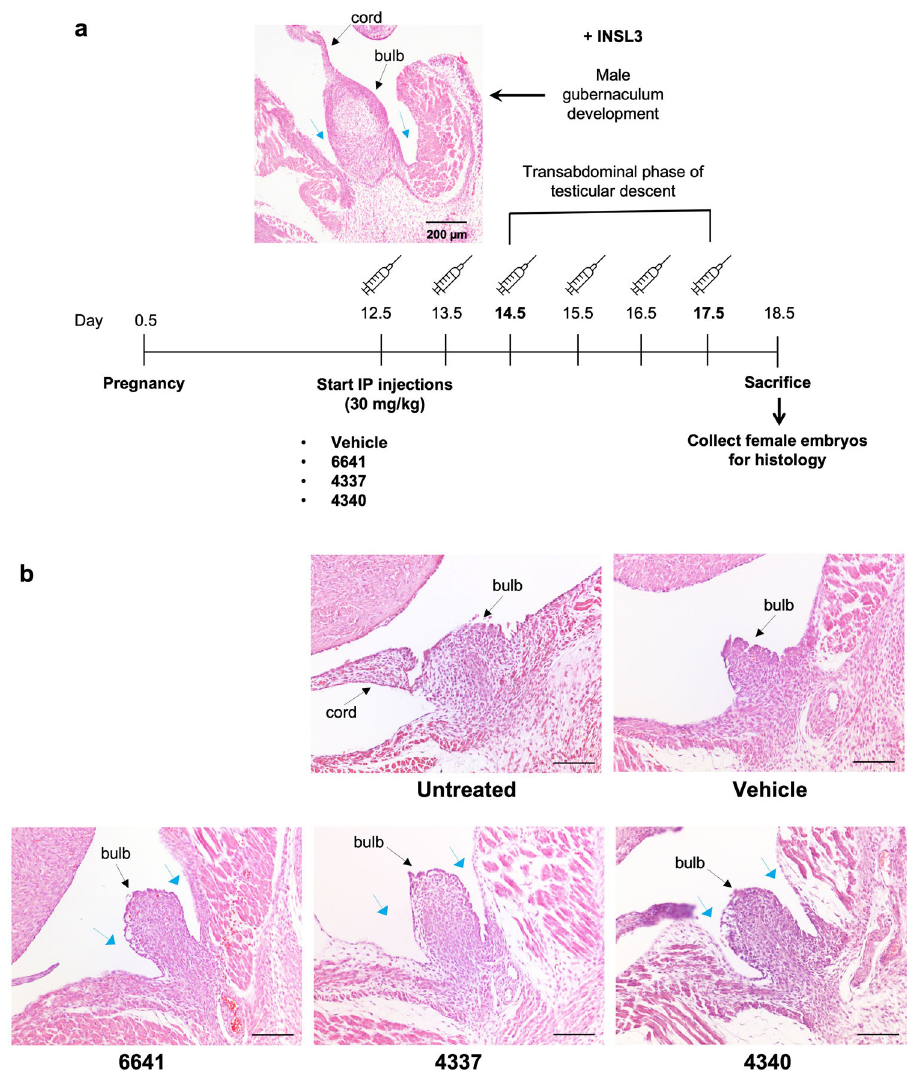
Fig. 3 RXFP2 agonists are biologically active and selective in vivo. a Diagram of the treatment protocol and representative histological section of the developed male gubernaculum at embryonic day 18.5 (upper left). b Representative histological sections showing a male-like invagination of the female gubernaculum in all compound-treated embryos (blue arrows). Four female embryos were analyzed per group. Scale bar = 100 µ